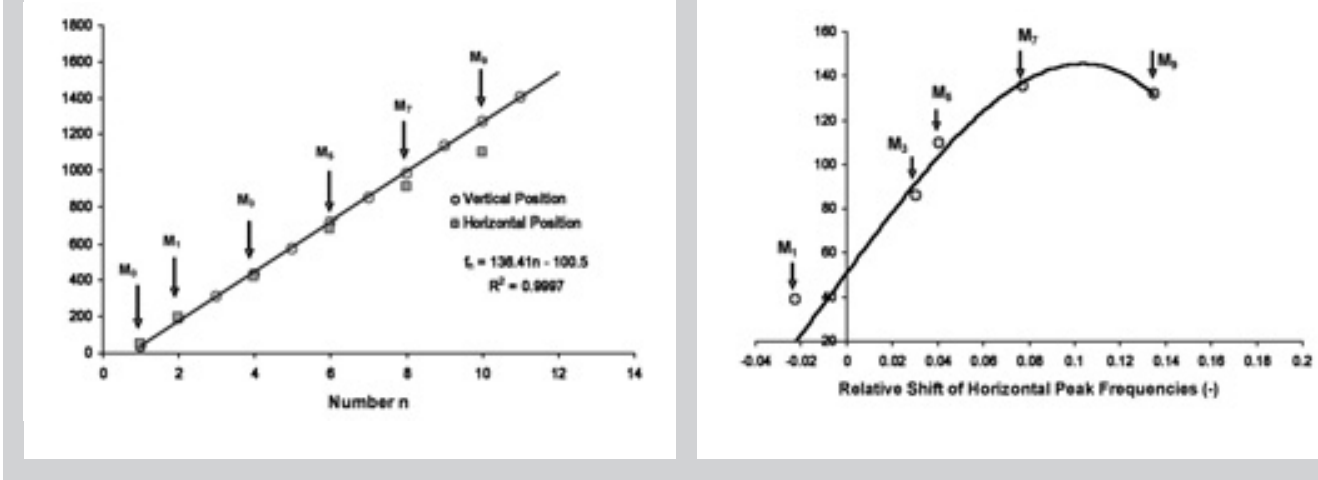
Figure 7 (left): Peak frequency plotted against number n (number of periods of the standing waves on the circumference of the meridian circle of the tested melon). The arrows determine position of the modes. Figure 8: Peak width W (vertical posi- tion) plotted against ratio of relative shift of horizon- tal peak frequencies (RS = (VF – HF)/VF, where VF and HF are vertical and hori- zontal peak frequencies,